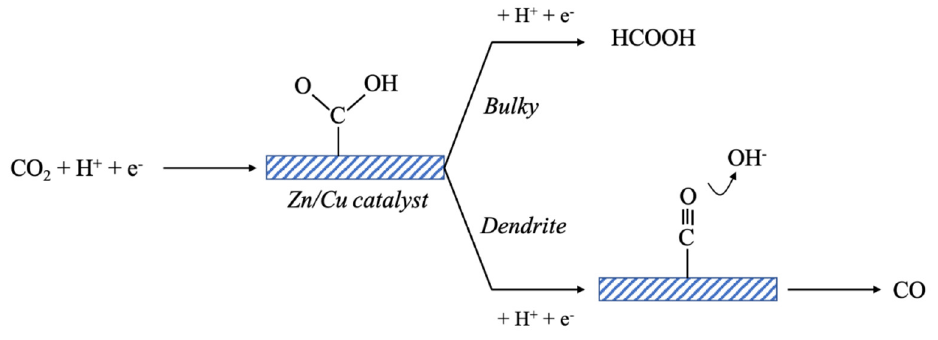
Table 3. Comparison of CO Faradaic efficiency on different Zn electrocatalysts in CO 2 RR.